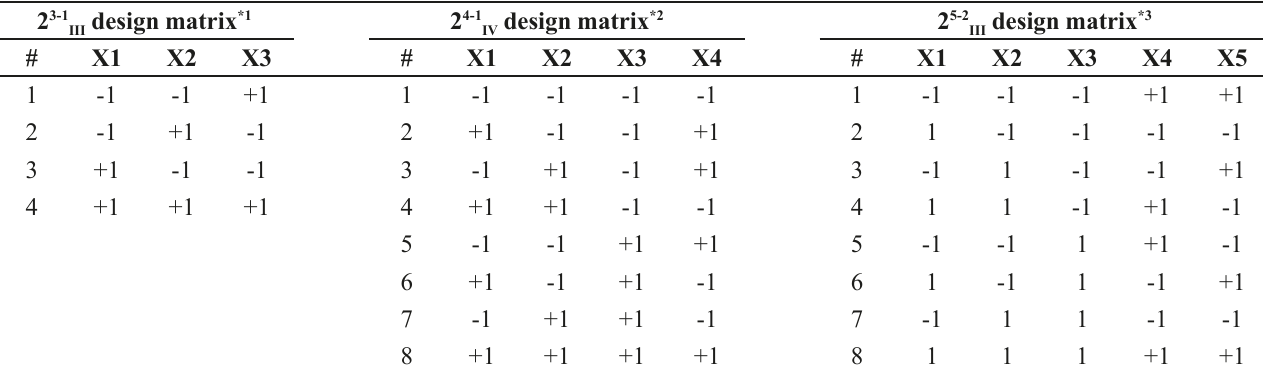
TABLE III – Half- and quarter-fractionate two-level factorial designs matrix for three (2 3-1 factors (X1 to X5)